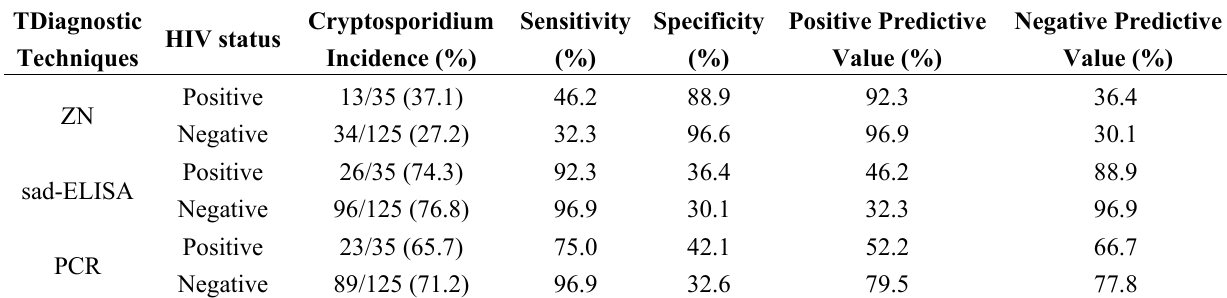
Table 2. Sensitivity, specificity, positive predictive value and negative predictive value of the techniques. TDiagnostic Cryptosporidium Sensitivity Specificity Positive Predictive Negative Predictive HIV status Techniques Incidence (%) (%) (%) Value (%) Value (%) Positive 13/35 (37.1) 46.2 88.9 92.3 ZN Negative 34/125 (27.2) 32.3 Positive 26/35 (74.3) 92.3 sad-ELISA Negative 96/125 (76.8) Positive 23/35 (65.7) 75.0 42.1 PCR Negative 89/125